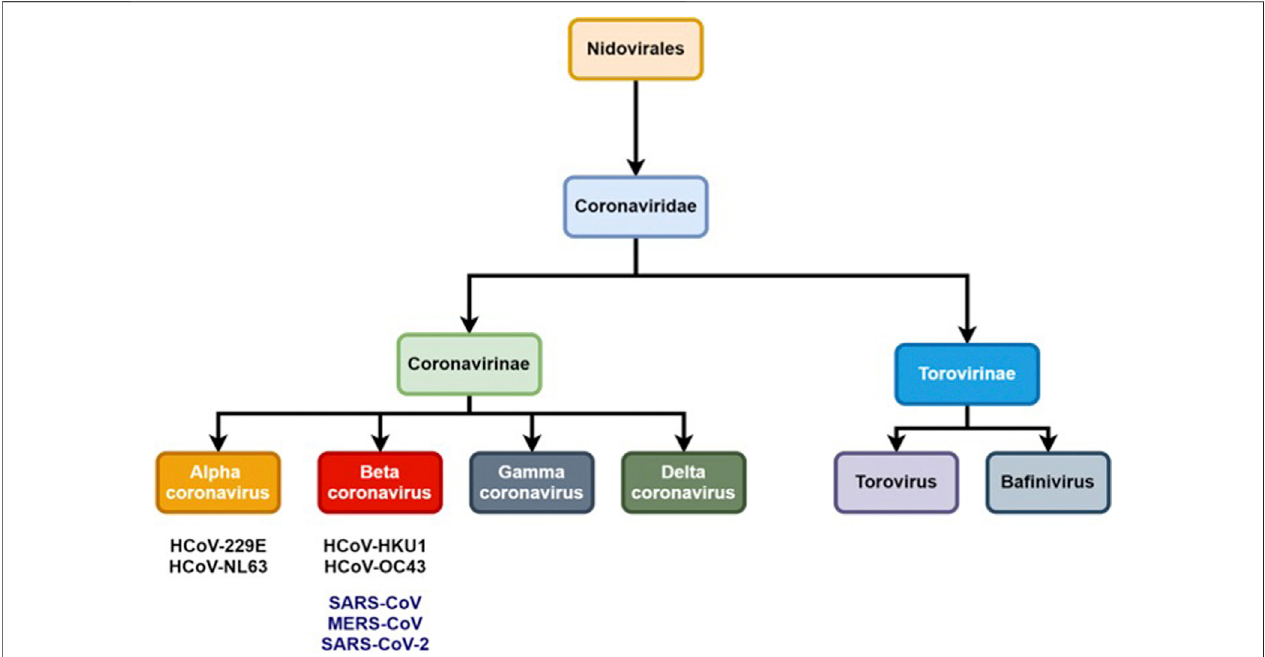
FIGURE 1 | Schematic representation of Coronaviridae